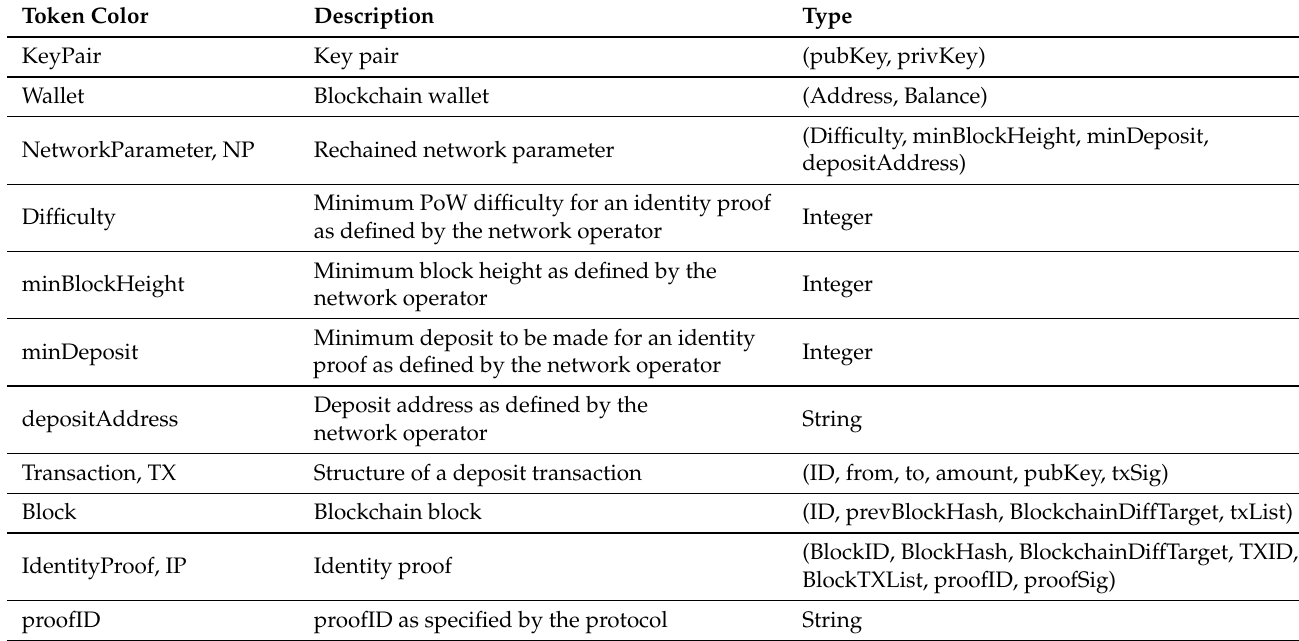
Table 3. Exemplary acronyms, names, and description of token colors of the Rechained CPN model—extension of [5]. Token Color